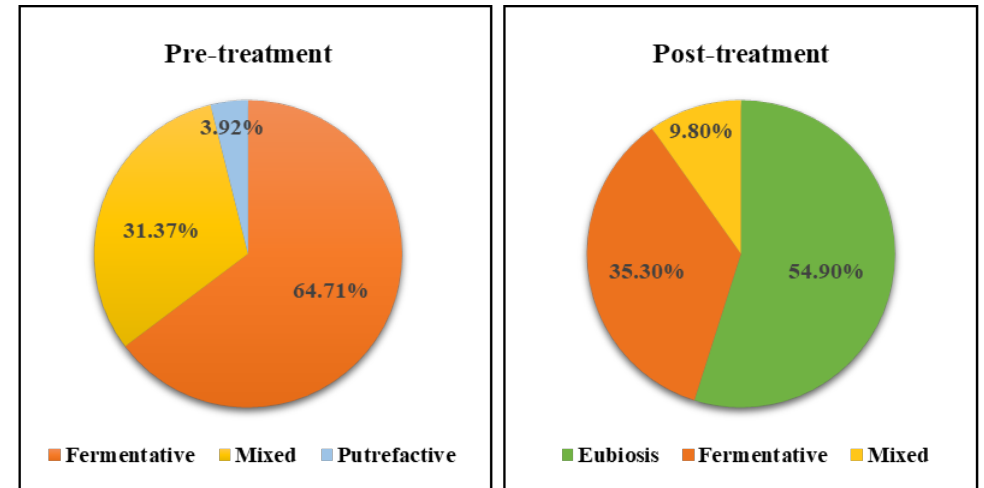
Figure 4. Percent distribution of dysbiosis types before and after treatment.